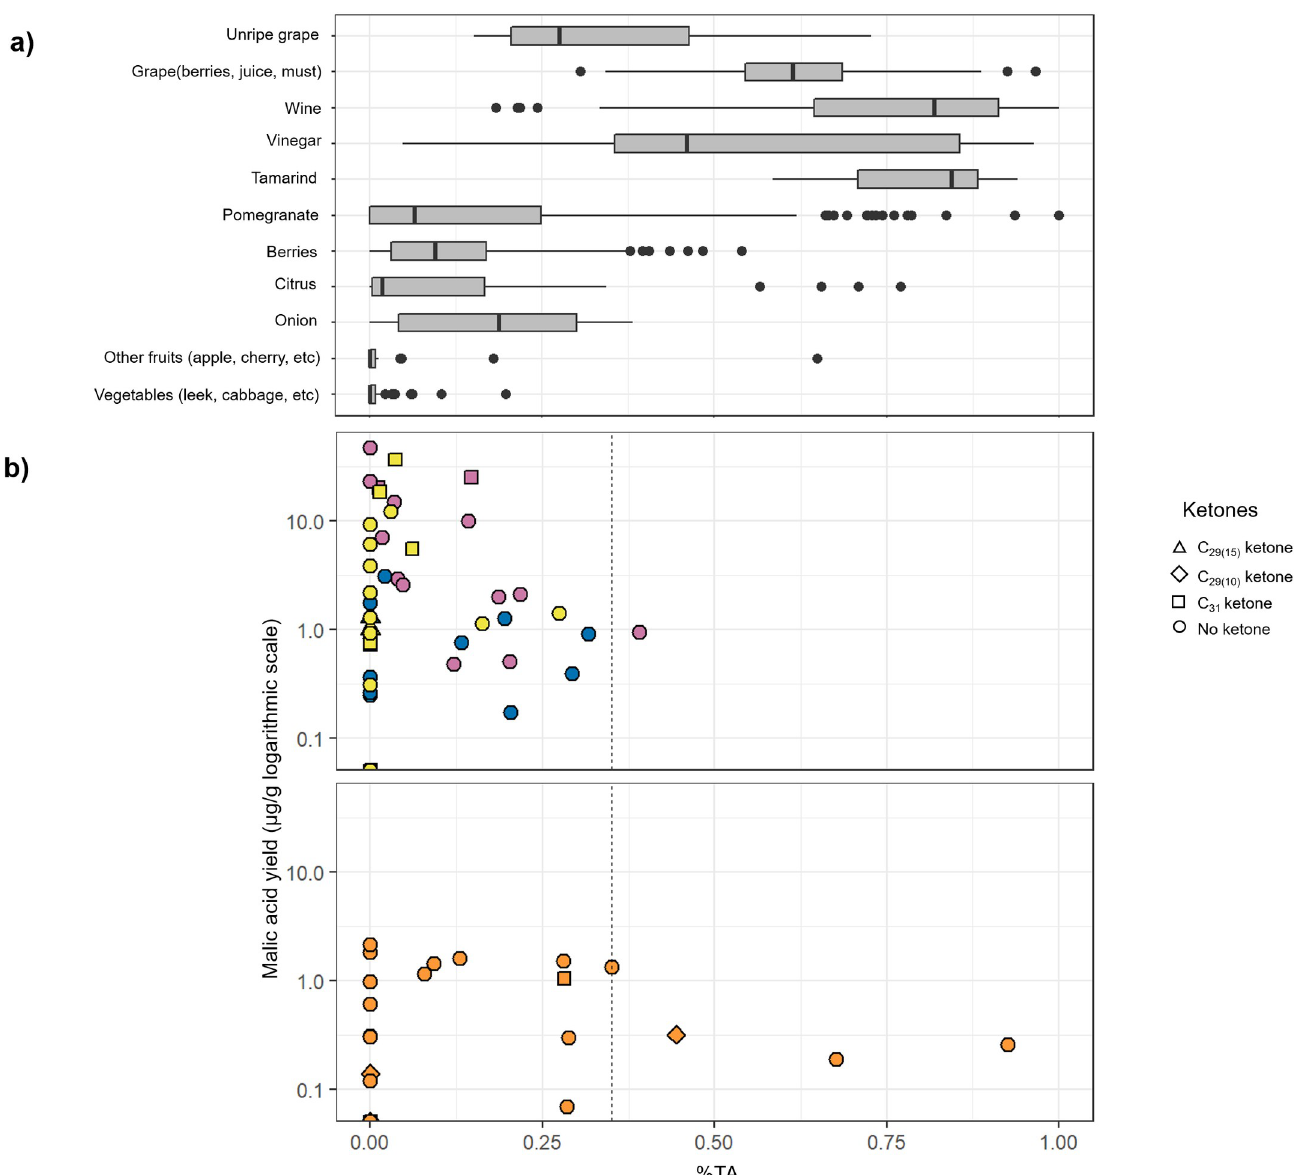
Fig 7. Malic acid yields and % tartaric acid (TA). a) Proportions of tartaric acid in various plants and plant products [17] (S1 Table); b) Proportions of tartaric acid in CLESP and Palermo cooking pots, plotted against the amount of malic acid extracted. % TA = tartaric acid/(tartaric + malic acid) [17]. C 29(10) ketone (nonacosane-10-one) indicates the presumed presence of broad-leaved sermountain ( Laserpitium latifolium ) [81] or ( Foeniculum vulgare ) (Fennel) [82]. C 29(15) ketone indicates the presumed presence of Brassica [77]. C 31 ketone (hentriacontane-16-one) indicates the presumed presence of leek ( Allium porrum ) in the ceramic samples [78–80,